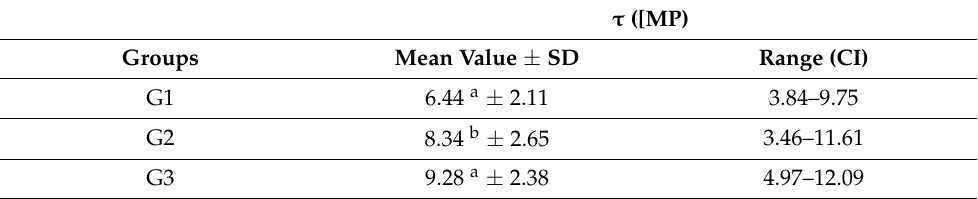
Figure 3. Comparison of average stress–strain values obtained in the shear bond strength test for 3 measurement groups: G1, G2 and G3, * p < 0.05.